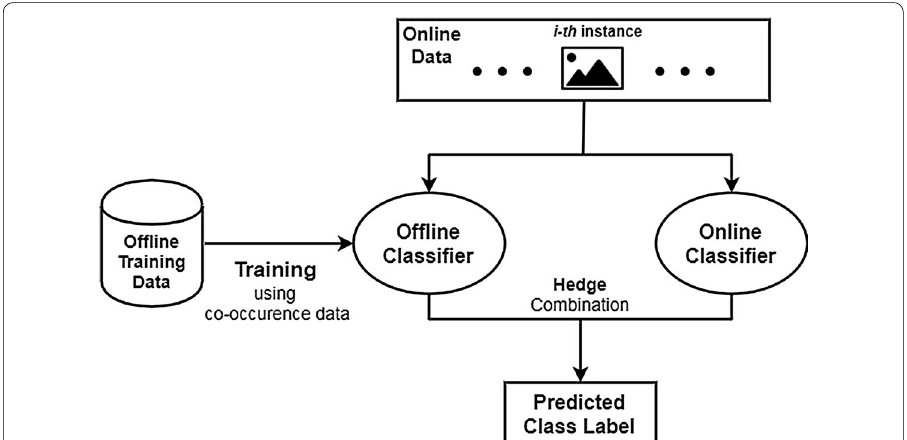
Fig. 2 Illustration of OHTWC adapted from [19] showing the use of offline and online classifiers to predict labels for an online